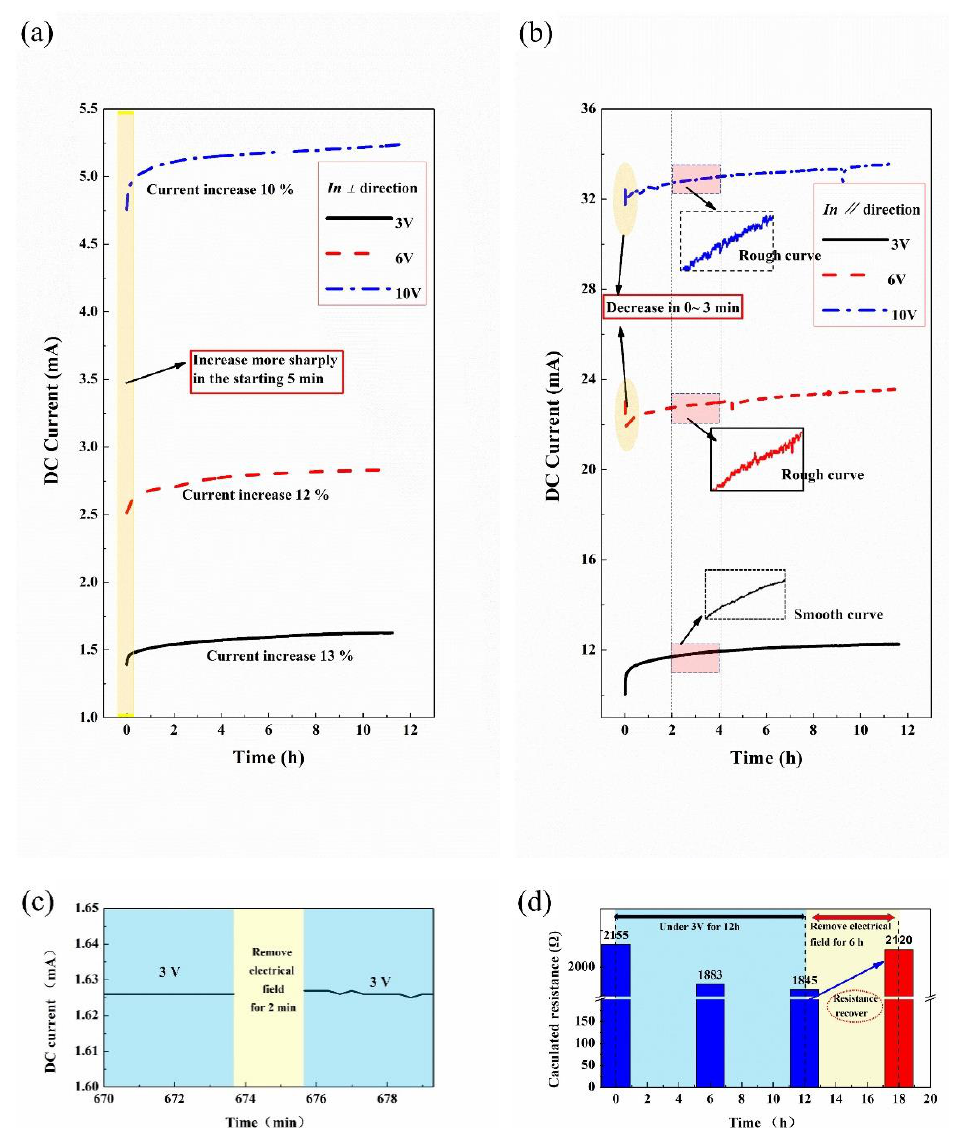
Figure 1. Electrical current changes (resistance relaxation) of printed composites within 12 h under DC voltages. ( a ) In ⊥ direction. ( b ) In ∥ direction. ( c ) Under 3 V for about 673 min, and then the electrical field removed for 2 min, and then the electrical field applied again. Resistance stayed constant with the state before the removal of electrical field. ( d ) Resistance recovers to its original state after the removal of electrical field for 6 h.